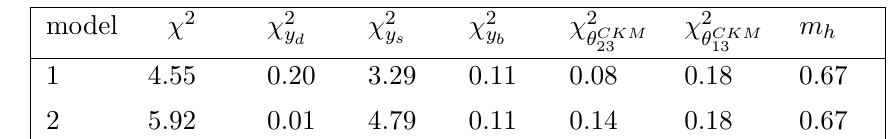
, as defined in eq. (3.23), for the best-fit points i < 0 . 01 are not shown. i = 123 . 1 GeV (with an assumed 3 GeV theo- h = 2 . 14 TeV obtained SUSY